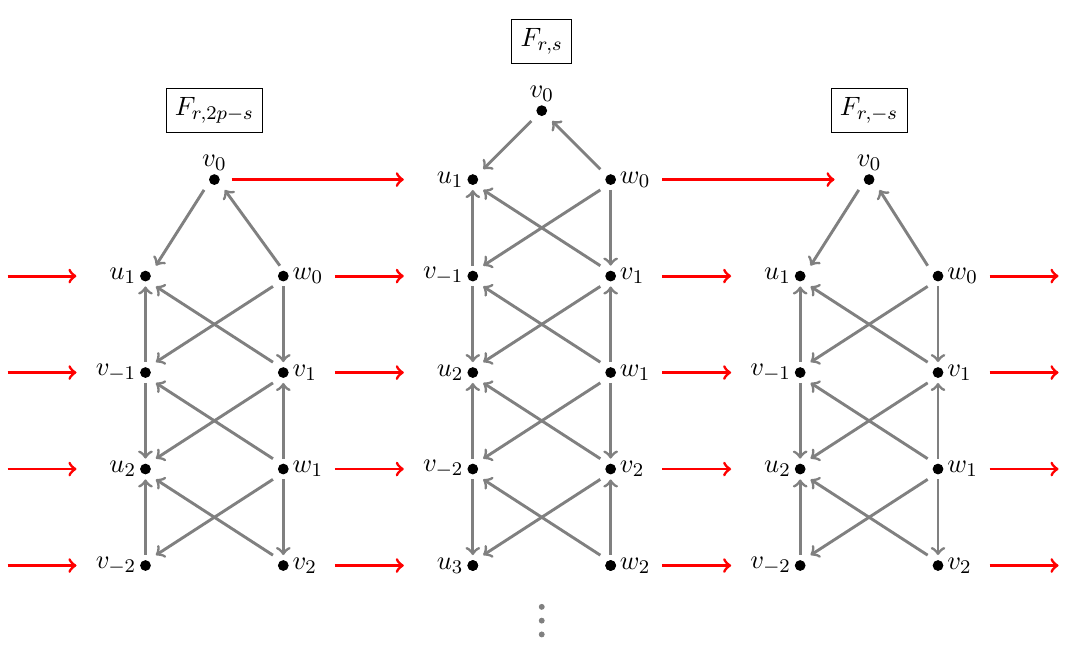
Figure 6 . BRST structure of Fock